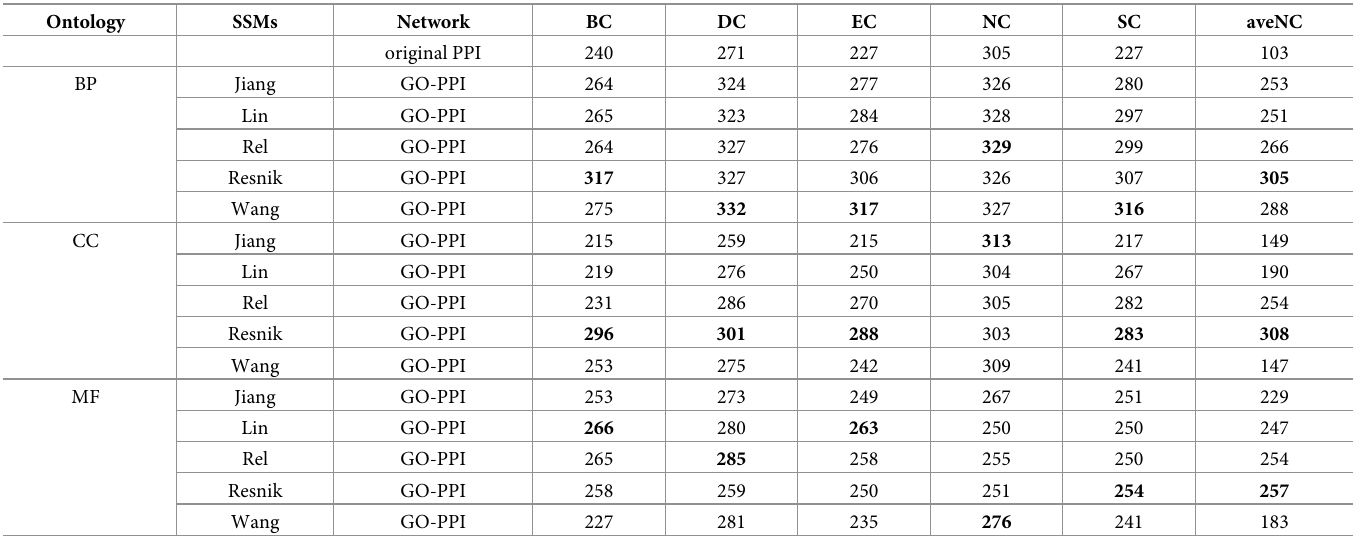
Table 7. The number of essential proteins detected by the six centrality methods under different strategies for the Krogan Extended dataset (top 600). Ontology